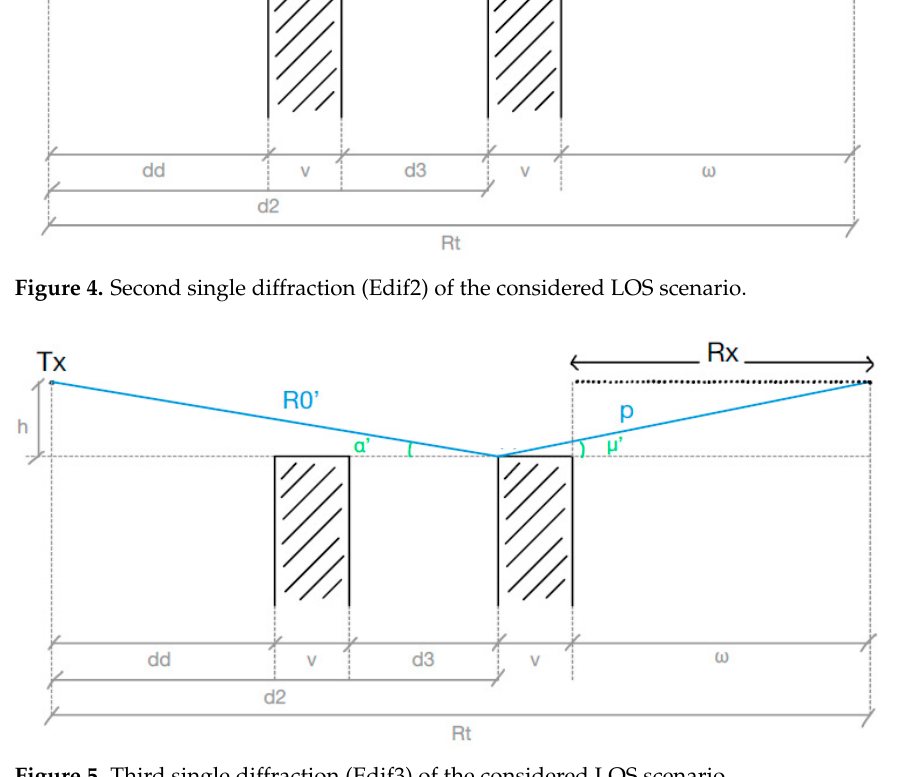
Figure 4. Second single diffraction (Edif2) of the considered LOS scenario.